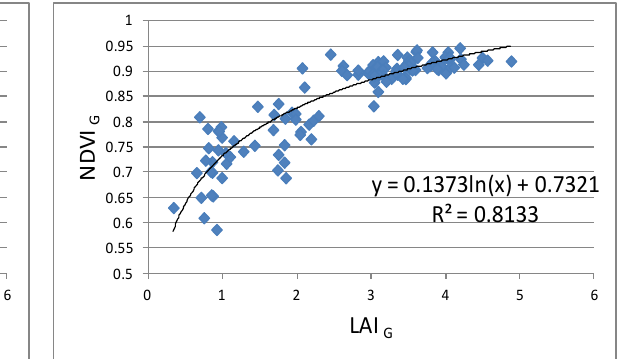
Figure 5: Relationship of LAI G and NDVI US for corn crop Figure 6: Relationship of LAI G and NDVI G for corn crop